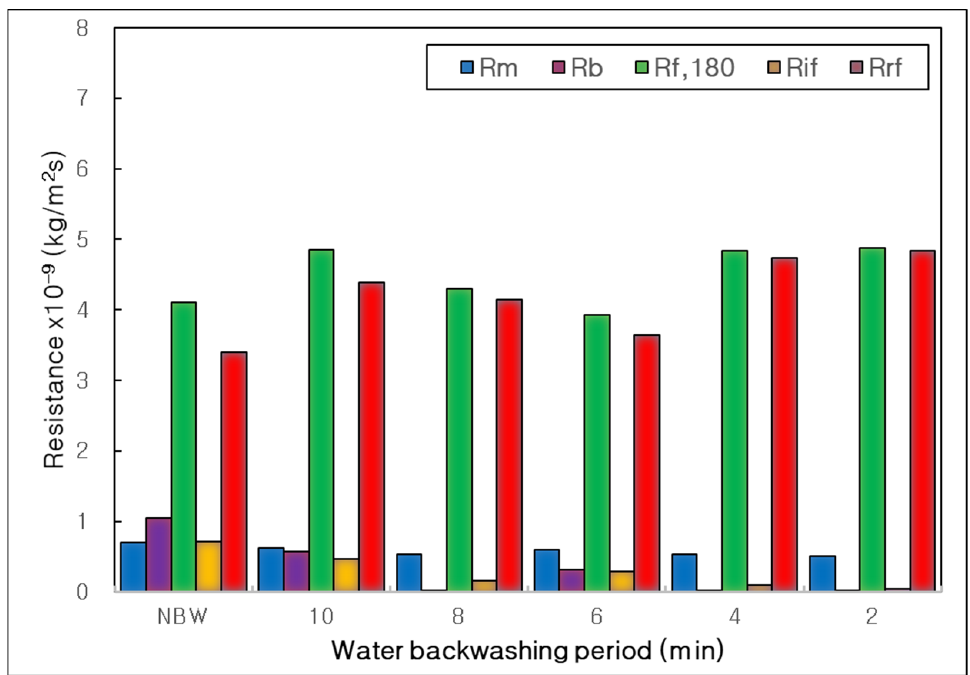
Figure 6. Influence of water backwashing period on resistances of membrane, boundary layer, final, irreversible and reversible membrane fouling (R m , R b , R f,180 , R if , R rf ) in the combined process of tubular alumina MF (NCMT-7231) and PP beads with UV irradiation and periodic water backwashing. Table 6. Water quality and treatment efficiency of turbidity in the combined process of tubular alumina MF (NCMT-7231) and PP beads for the influence of water backwashing period. Turbidity BP (min)